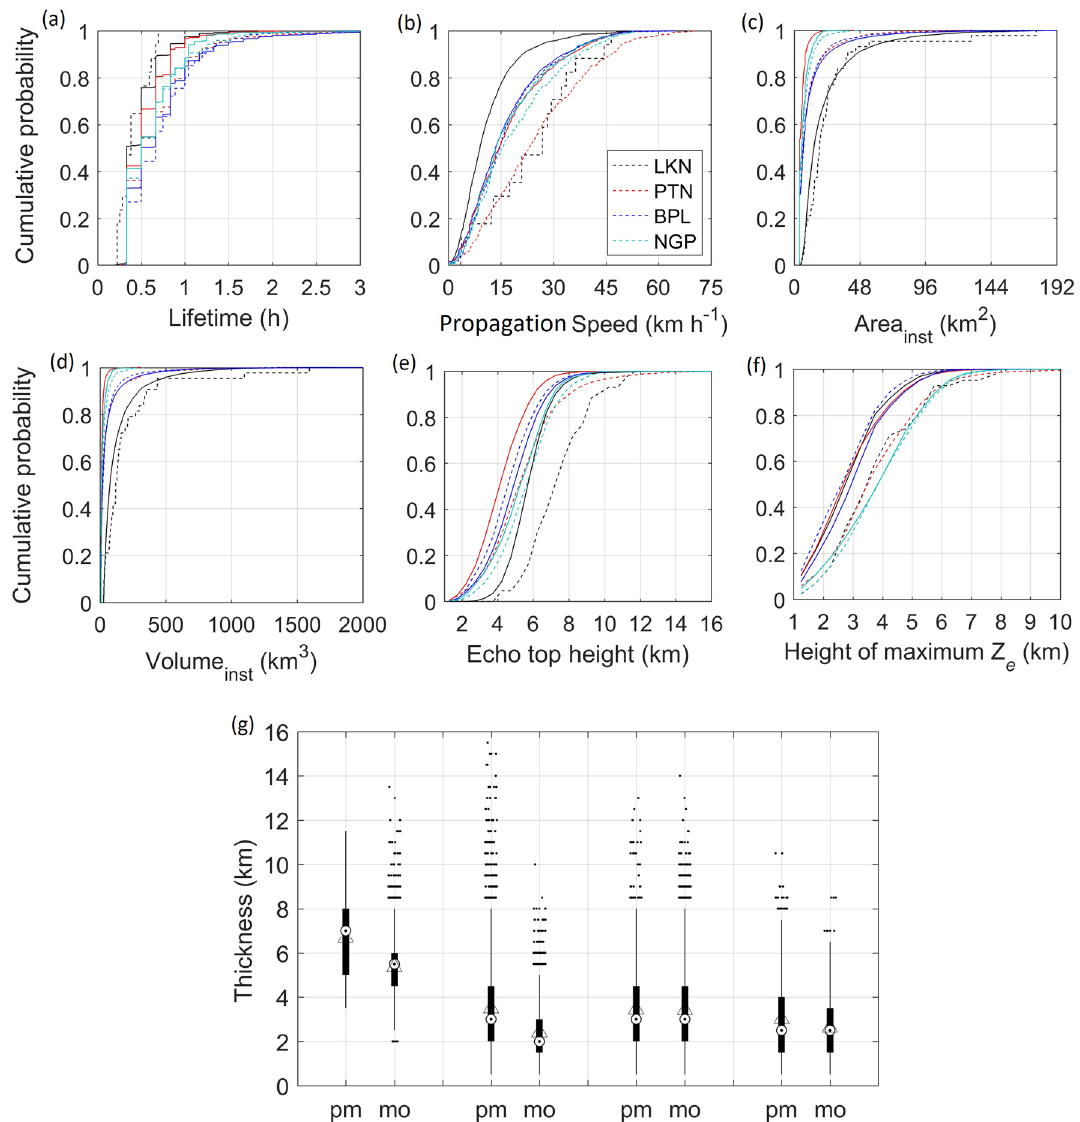
Figure 4. The cumulative probability distributions of ( a ) lifetime, ( b ) propagation speed, ( c ) instantaneous area, ( d ) instantaneous volume, ( e ) echo top height, and ( f ) height of maximum Z e of storms. The data corresponding to the pre-monsoon and monsoon seasons are shown by dashed and solid curves respectively. ( g ) Distributions of instantaneous thicknesses of storms during monsoon and pre-monsoon seasons. The boxplot includes a thick bar of inter-quartile range (IQR) of data and median shown by the symbol of the black dot within a white filled circle. The upper and lower extremities of thin vertical lines are the limits of 1.5 × IQR above and lower side of the 75th and 25th percentile of the data. The symbol ‘triangle’ onto the boxplot denotes the mean value of the distribution. The symbols of the black dot are the outliers in the distributions. Here, abbreviations ‘pm’ and ‘mo’ refer to the pre-monsoon and monsoon seasons